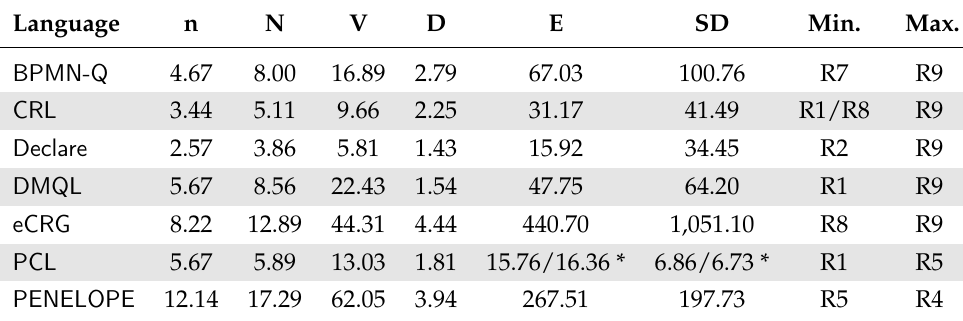
Table 17. Complexity measured by metrics proposed in